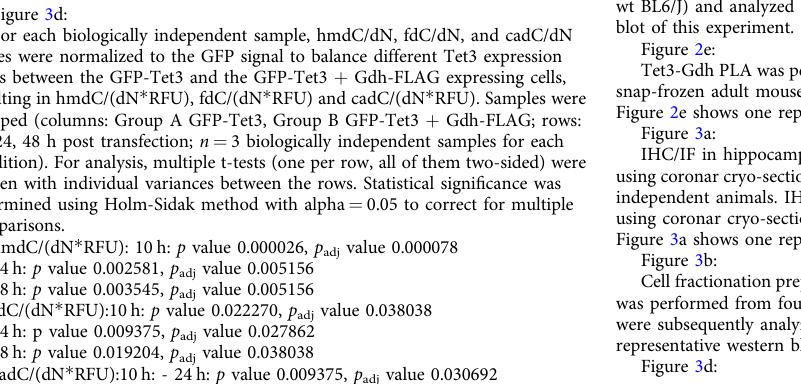
Figure 2d: coIP of endogenous Tet3 and a corresponding control coIP (using a non- targeting anti-goat antibody) was performed twice using two biologically independent nuclear lysate preparations from total murine brain (three months old wt BL6/J) and analyzed by western blotting. Figure 2d shows one representative blot of this experiment. Figure